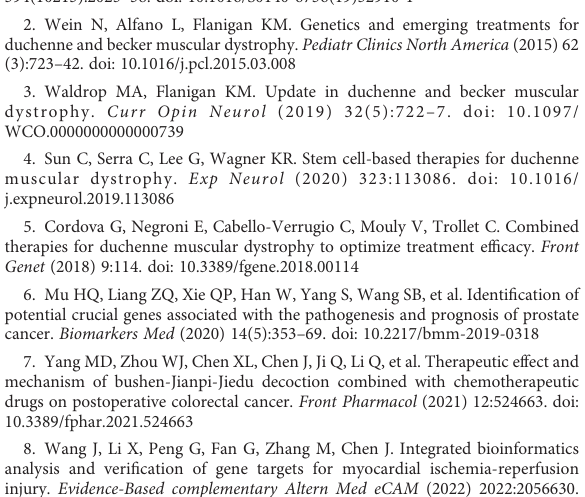
SUPPLEMENTARY FIGURE 1 Pearson's correlation analysis between the four proteins and the clinical characteristics of